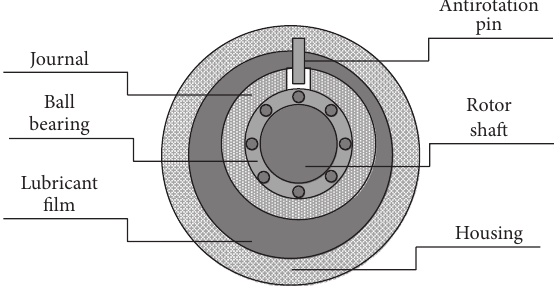
Figure 1: Schematic diagram of a squeeze film